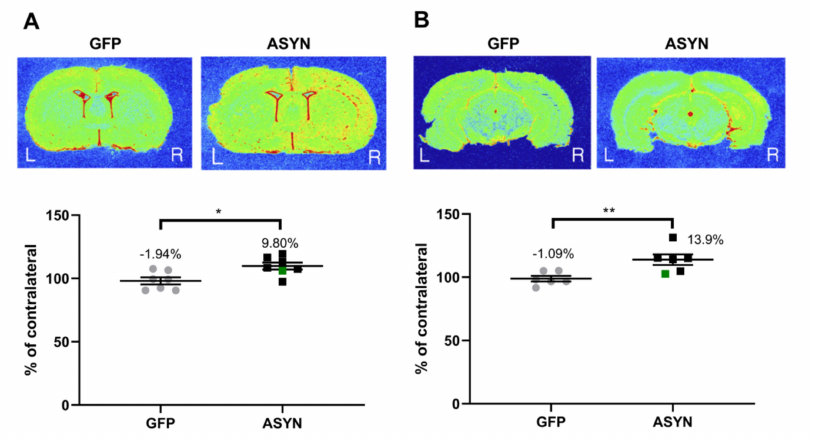
Figure 7. Representative autoradiograms of [ 3 H]PK11195 binding to TSPO in the ( A ) striatum and ( B ) SN. Graphs at the bottom of each panel show the ipsilateral value as percentage of the contralateral binding. The green square represents the animal with lateral ASYN expression in the striatum. SN: GFP ( n = 6), ASYN ( n = 6), Striatum: GFP ( n = 8), ASYN ( n = 7). We present the data as mean ± SEM, * p < 0.05, ** p < 0.01 (unpaired t-tests). Distance from bregma − 5.8 and − 6.04 for SN levels (( A ), left and right, respectively) and 0.2 mm for striatum ( B